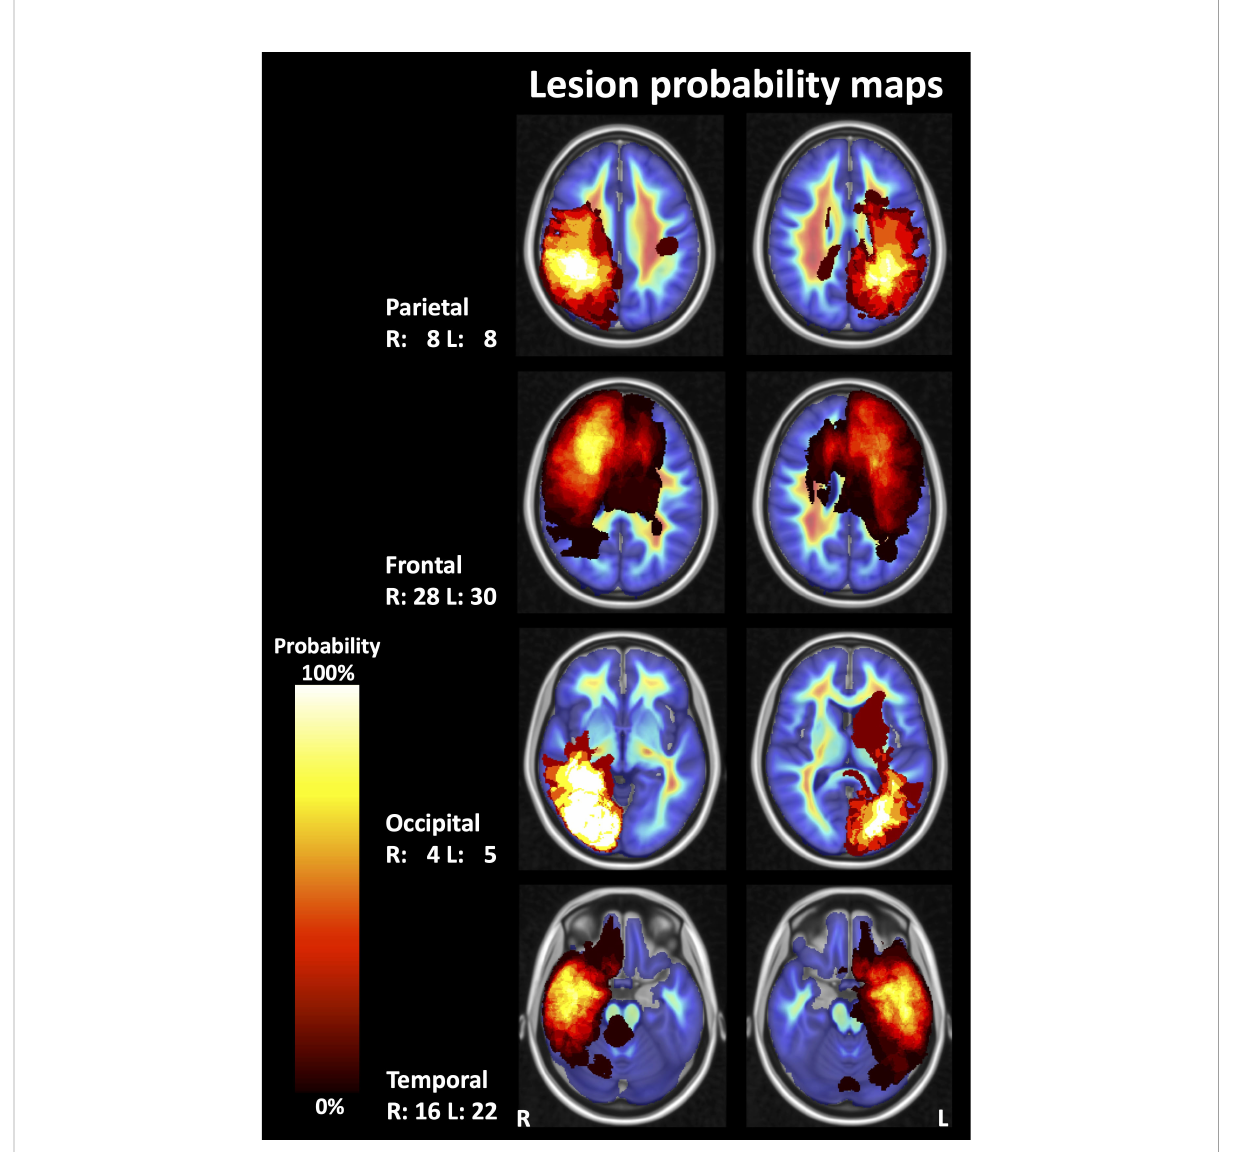
FIGURE 3 Probability maps for lesion localization. Compound lesion maps comprising T2-weighted fl uid-attenuated inversion recovery (FLAIR) hyperintense lesions, contrast-enhancing lesions, resection cavities, and lesions with pathologically increased FET (O-(2-[ 18 F] fl uoroethyl)-L- tyrosine) uptake on PET images are shown superimposed on images depicting the mean fi ber density in a control group (representative sections of the MNI-152 standard brain template). R, right; L, left; numbers, number of